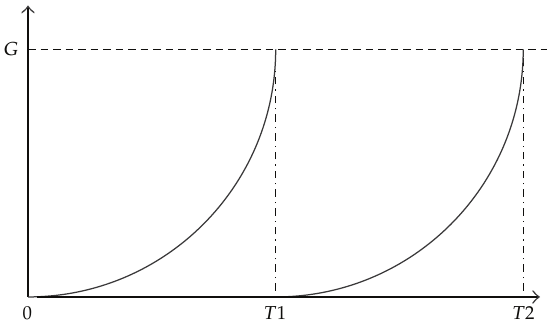
Figure 4: Cyclical trend of track state condition